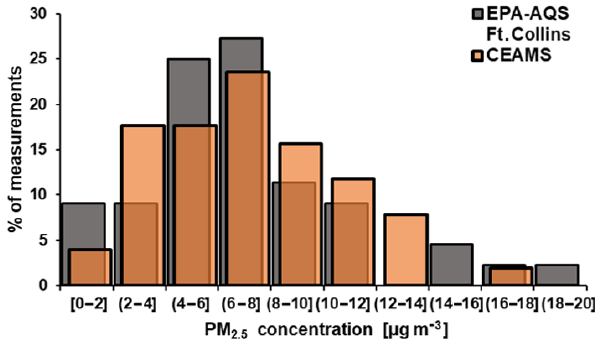
Figure 2. Distribution of 48h average filter mass concentrations collected by CEAMS participants during the pilot campaign in northern Colorado in fall and winter 2017, and 24h average PM 2 . 5 concentrations measured at the EPA-AQS site in Fort Collins, Col- orado, for 28 October–15 December 2017.